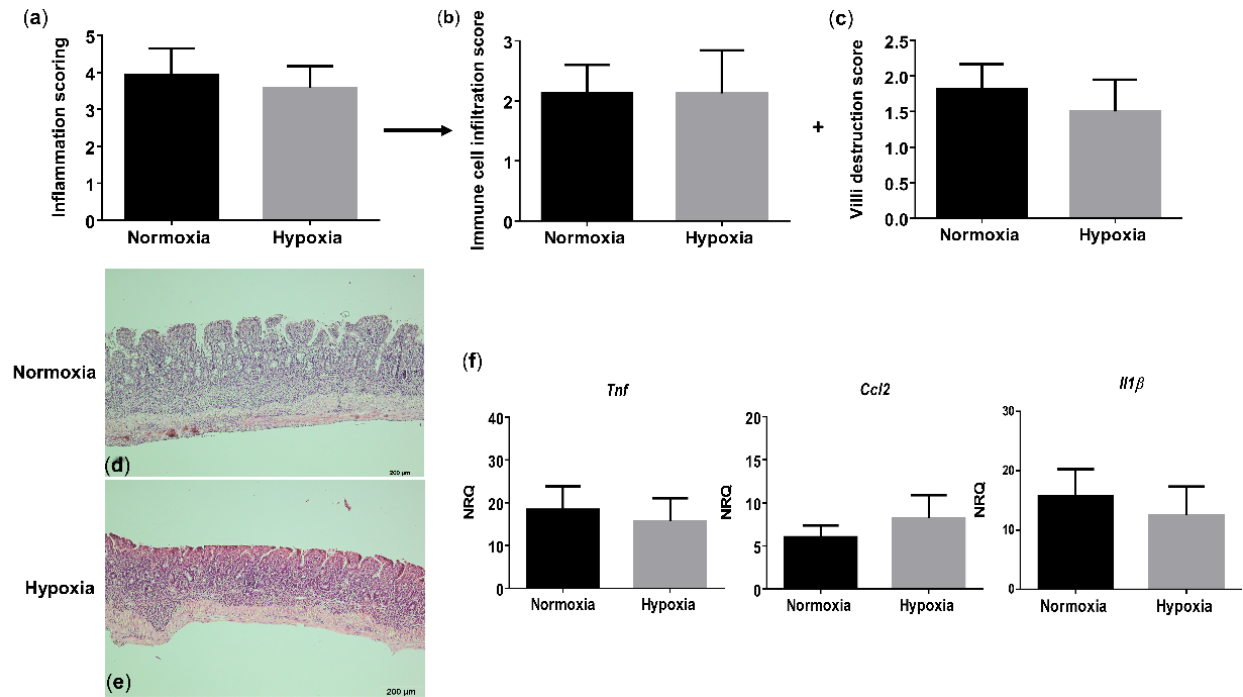
Figure 5. Long-term environmental hypoxia exposure to TNF Δ ARE/+ mice does not protect against ileitis. ( a ) Total histological inflammation score in TNF ∆ ARE/+ mice housed in normoxia and hypoxia, comprising the subscores: ( b ) immune cell infiltration and ( c ) villi destruction. Representative images from H&E sections of the distal ileum from ( d ) a TNF ∆ ARE/+ mouse housed in normoxia; ( e ) a TNF Δ ARE/+ mouse housed in hypoxia. ( f ) mRNA expression levels of Tnf, Ccl2 and Il1 β in WT littermates housed in normoxia and hypoxia. Data are represented as the mean ± SEM. NRQ: Normalized relative quantities.